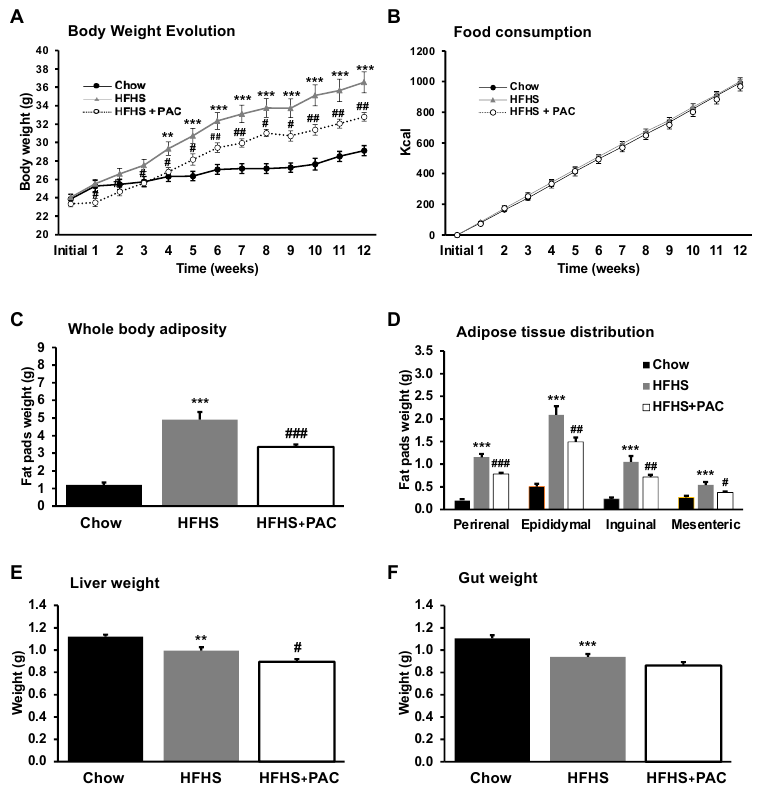
Figure 1. Effect of PAC on body weight gain, food intake and organs weight. Mice were fed either a standard chow diet or a high-fat, high-sucrose diet (HFHS) ± 200 mg/kg polyphenol proanthocyanidin-rich fraction (PAC) body weight/day by gavage (HFHS + PAC) for 12 weeks. Chow diet and HFHS-fed mice were gavaged with a water vehicle. ( A ) body weight gain, ( B ) energy intake, ( C ) whole adipose tissue weight (as a total of collected fat pads) and ( D ) its tissue distribution, ( E ) liver and ( F ) gut weights were measured as described in Materials and Methods. Results are presented as mean ± SEM for n = 12–16 mice/group. ** p < 0.01, *** p < 0.001 vs. chows; # p < 0.05, ## p < 0.01, ### p < 0.001 vs. HFHS